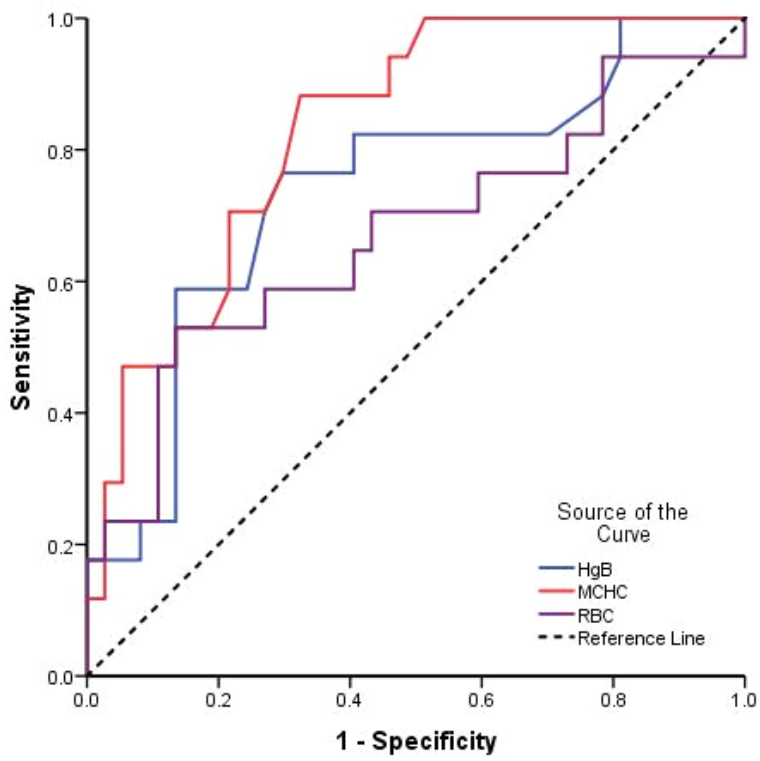
Figure 6. Predictive accuracy of blood cell indices for the occurrence of strangulation in hernia . A receiver operating curve (ROC) with an area under a curve (AUC) was used to determine the predictive accuracy of blood cell indices for strangulation. HgB: Haemoglobin; MCHC: Mean cell haemoglobin concentration; RBC: Red blood cell; p≤0.05 was considered